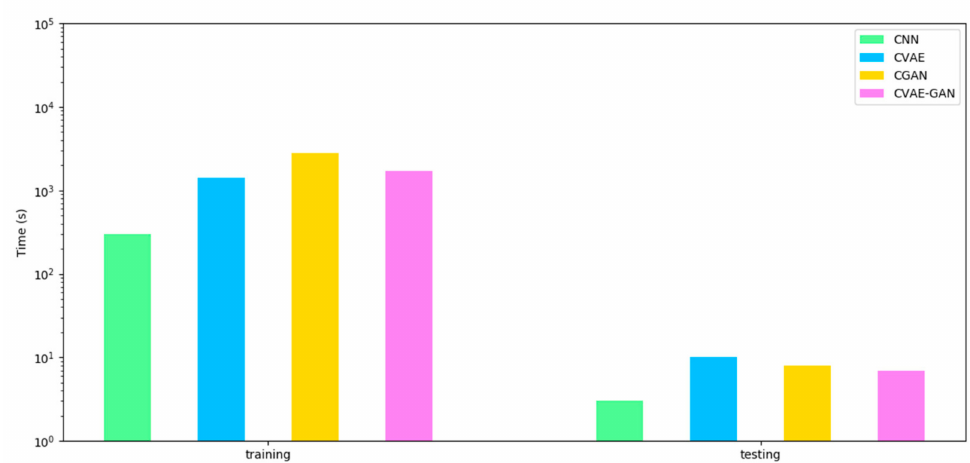
Figure 10. Classification performance of confusion matrices on real and synthetic